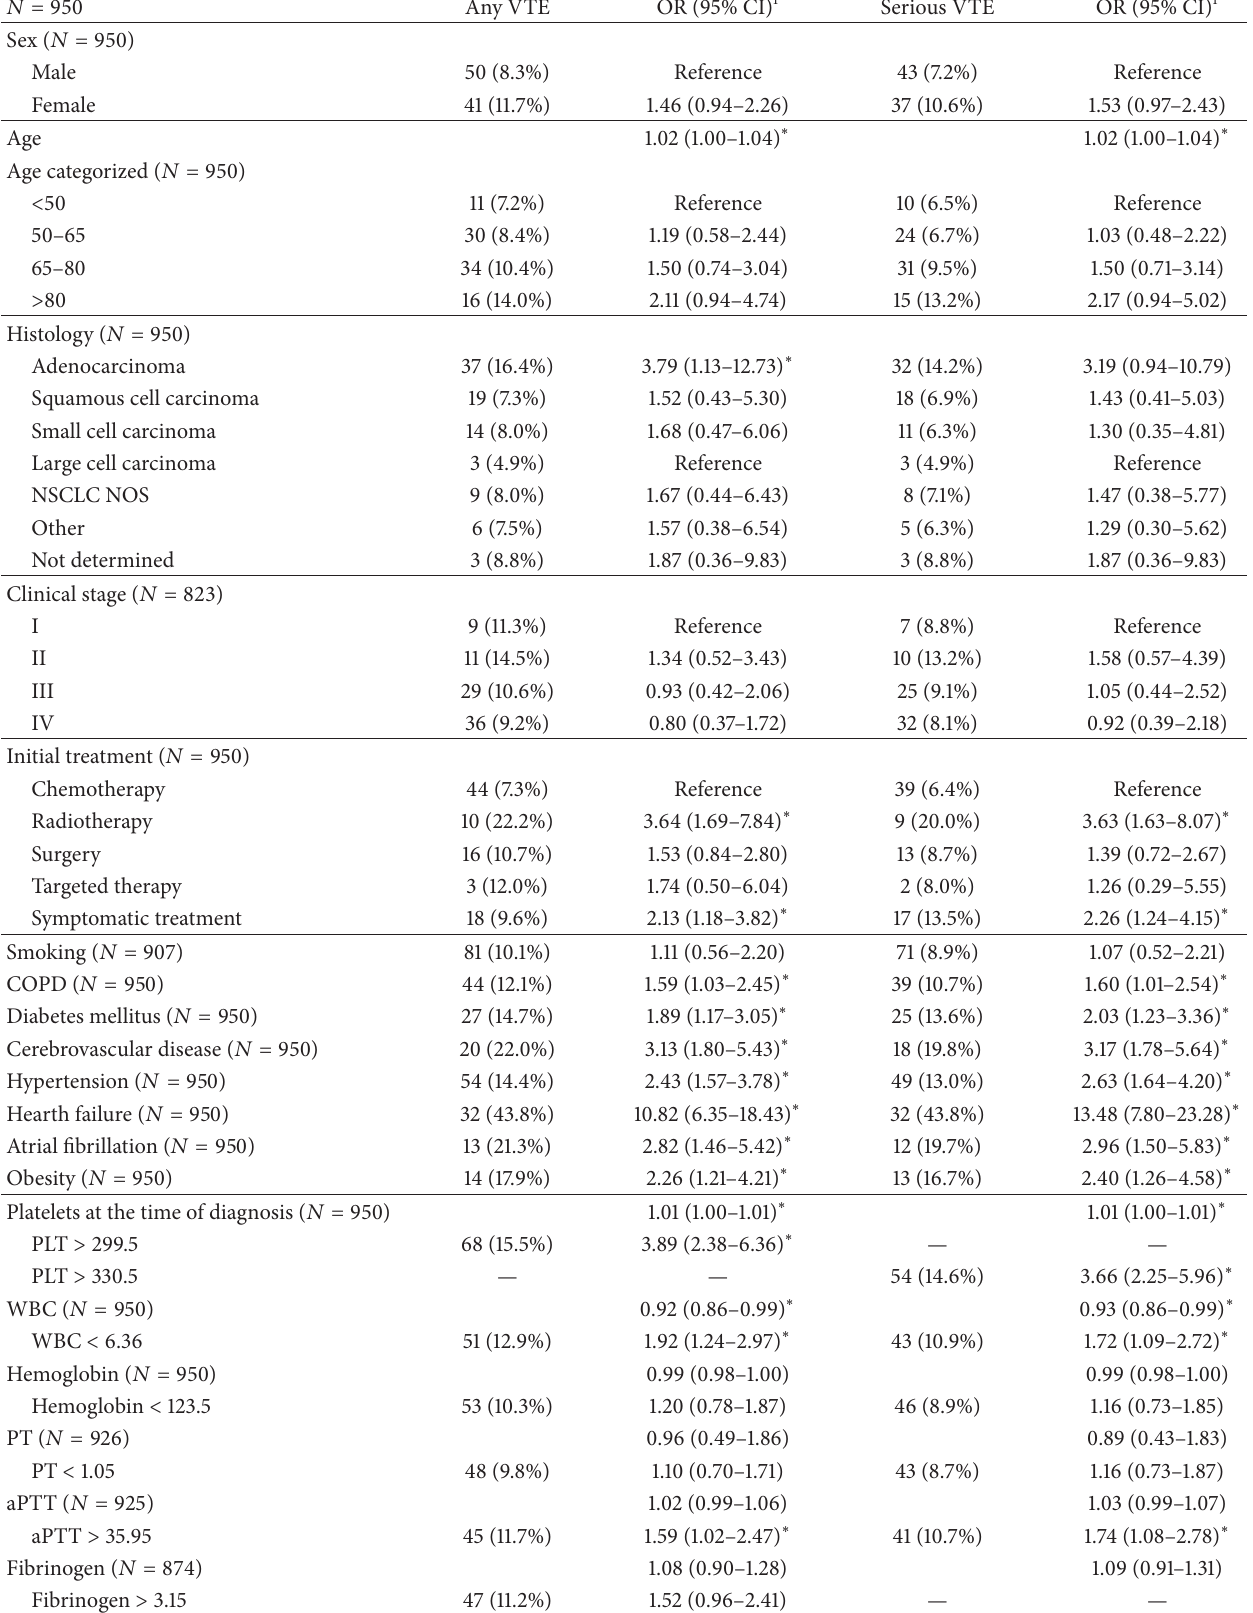
Table 3: Relationship between potential predictors and occurrence of thromboembolic